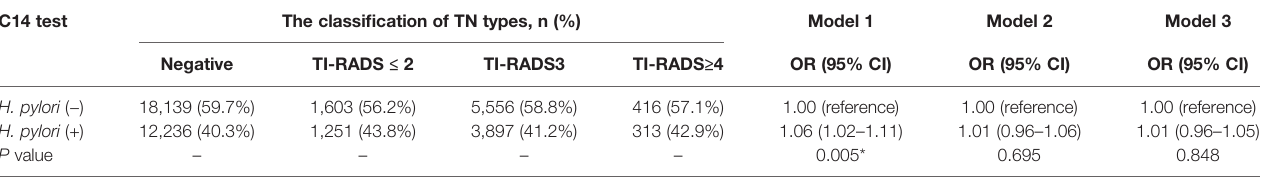
TABLE 4 | Ordinal logistic regression analysis of the H. pylori infection and the severity of TN